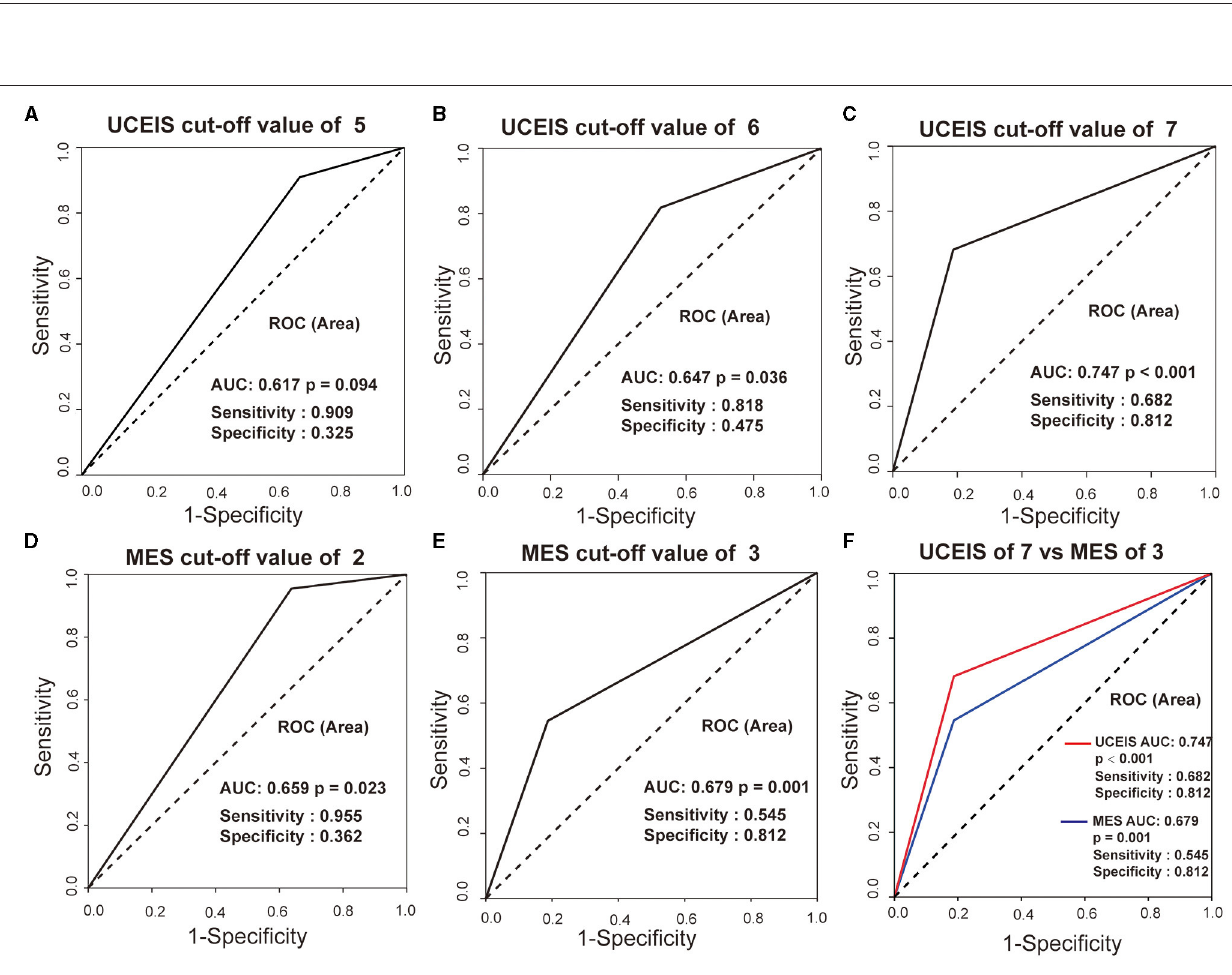
FIGURE 3 | Pearson’s correlation test was performed to analyze the relationship among UCEIS, MES, and pouchitis disease activity index (PDAI). (A) Significant correlations existed between the UCEIS and PDIA ( R = 0.6595, p = 0.0045) and between (B) MES and PDAI ( R = 0.5492, p = 0.0081).